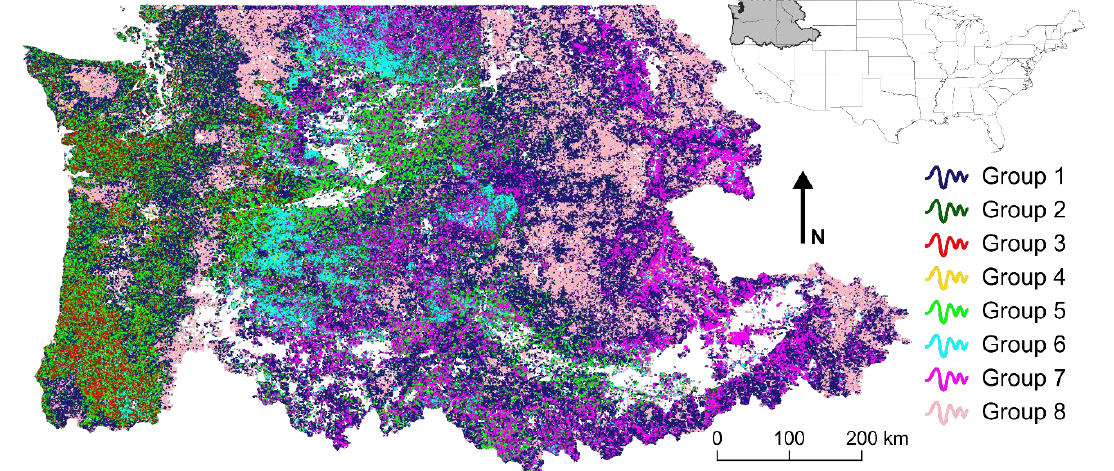
Figure 6. Spatial occurrence of stream reaches in each calibration group as determined by the parameter regionalization methods.